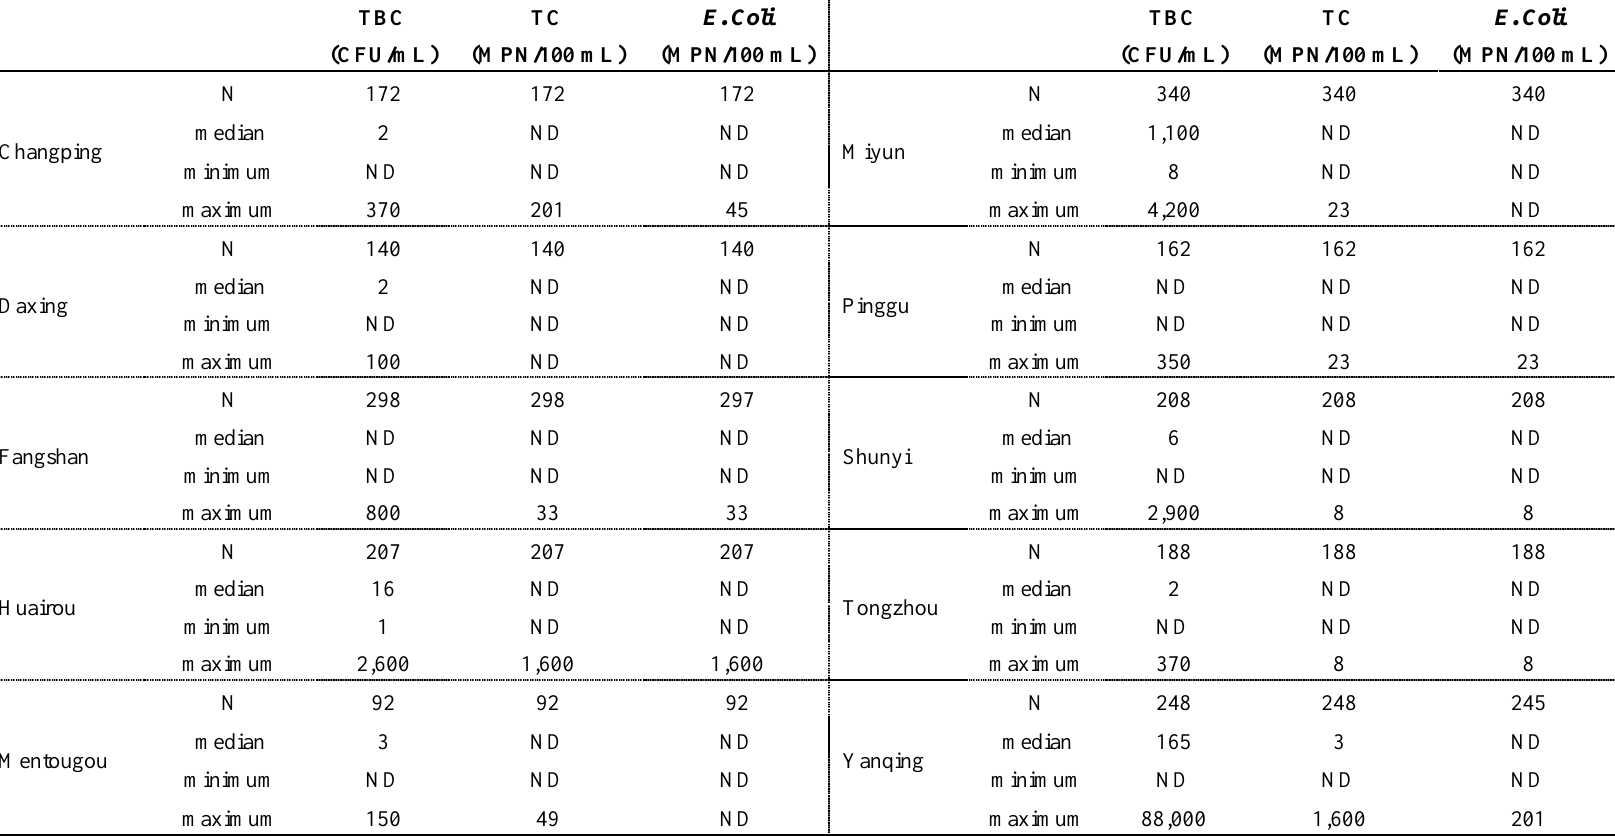
Table 1. Descriptive statistics of bacterial contamination in drinking